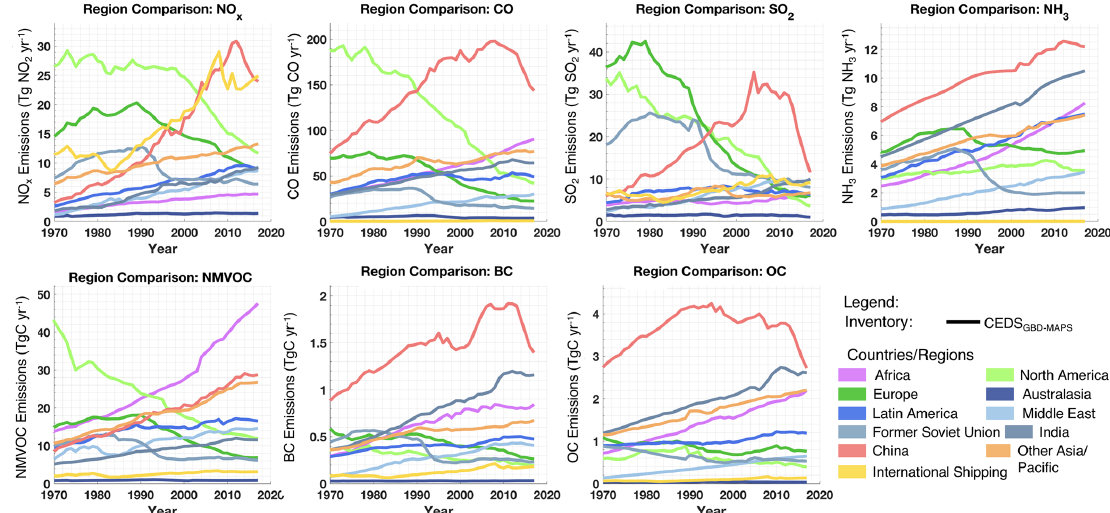
Figure 8. Time series of global annual CEDS GBD-MAPS emissions of NO x , CO, SO 2 , NH 3 , NMVOCs, BC, and OC for all sectors and fuel types, split into 11 regions and countries (defined in Table